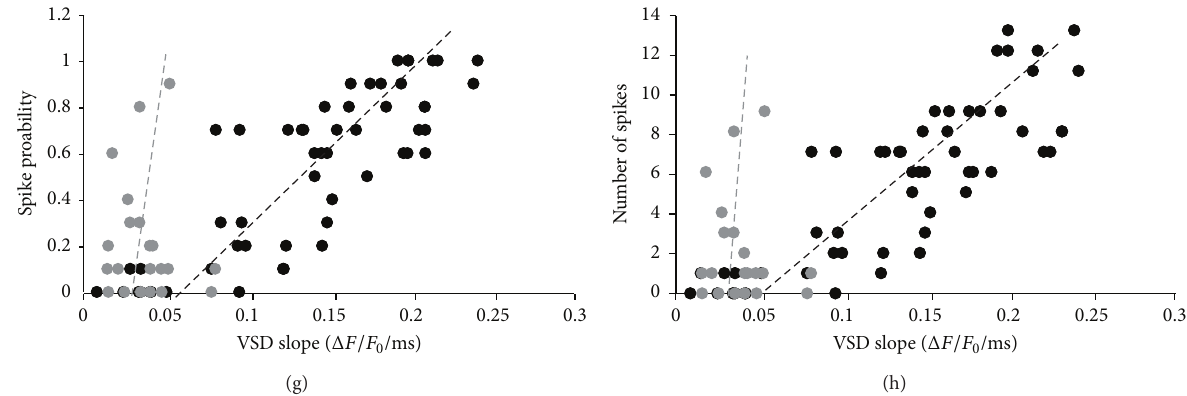
Figure 3: Correlation of VSD signals and intracellular granule cell activity. (a) VSD signals with a small slope or large slope were obtained from ROIs corresponding to the somata of GrCs recorded intracellularly and compared to electrical traces. The recording from a GrC in a low- responding region shows a prevalence of EPSPs (10 consecutive sweeps are superimposed). The recording from a GrC in a high-responding region shows larger EPSPs and EPSP-spike complexes (10 consecutive sweeps). (b) The histogram shows the number of spikes emitted by GrCs during 10 consecutive sweeps in ROIs belonging to group 1 or group 2. (c) Correlation between normalized peak amplitude and the probability of eliciting at least one action potential per GrC during 10 consecutive sweeps. Linear regression lines are shown for both clusters of VSD signals emerging from PCA (dashed black line, group 1 ROIs, 𝑅 2 = 0.2 , Fisher’s 𝐹 -test 𝑝 = 0.04 ; dashed gray line, group 2 ROIs, 𝑅 2 = 0.37 , Fisher’s 𝐹 -test 𝑝 = 0.02 ). (d) Correlation between normalized time-to-peak and the probability of eliciting at least one action potential per GrC during 10 consecutive sweeps. Linear regressions are shown for both clusters of VSD signals emerging from PCA (dashed black line, group 1 ROIs, 𝑅 2 = 0.15 , Fisher’s 𝐹 -test 𝑝 = 0.06 ; dashed gray line, group 2 ROIs, 𝑅 2 = 0.16 , Fisher’s 𝐹 -test 𝑝 = 0.03 ). (e) Correlation between the vector slope of VSD signals and the probability of eliciting at least one action potential per GrC. Linear regressions are shown for both clusters of VSD signals emerging from PCA (dashed black line, group 1 ROIs, 𝑅 2 = 0.85 , Fisher’s 𝐹 -test 𝑝 = 10 − 14 ; dashed gray line, group 2 ROIs, 𝑅 2 = 0.89 , Fisher’s 𝐹 -test 𝑝 = 10 − 15 ). (f) Correlation between the slope of the VSD signals and the total number of emitted spikes per GrC. Linear regressions are shown for both clusters of VSD signals emerging from PCA (dashed black line, group 1 ROIs, 𝑅 2 = 0.82 , Fisher’s 𝐹 -test 𝑝 = 10 − 11 ; dashed gray line, group 2 ROIs, 𝑅 2 = 0.84 , Fisher’s 𝐹 -test 𝑝 = 10 − 13 ). (g) Correlation between the initial slope of the VSD signals and the probability of eliciting at least one action potential per GrC. Linear regressions are shown for both groups of VSD signals emerging from PCA (dashed black line, group 1 ROIs, 𝑅 2 = 0.91 , Fisher’s 𝐹 -test 𝑝 = 10 − 16 ; dashed gray line, group 2 ROIs, 𝑅 2 = 0.78 , Fisher’s 𝐹 -test 𝑝 = 10 − 9 ). (h) Correlation between the initial slope of the VSD signals and the total number of emitted spikes per GrC. Linear regressions are shown for both groups of VSD signals emerging from PCA (dashed black line, group 1 ROIs, 𝑅 2 = 0.92 , Fisher’s 𝐹 -test 𝑝 = 10 − 14 ; dashed gray line, group 2 ROIs, 𝑅 2 = 0.8 , Fisher’s 𝐹 -test 𝑝 = 10 − 7